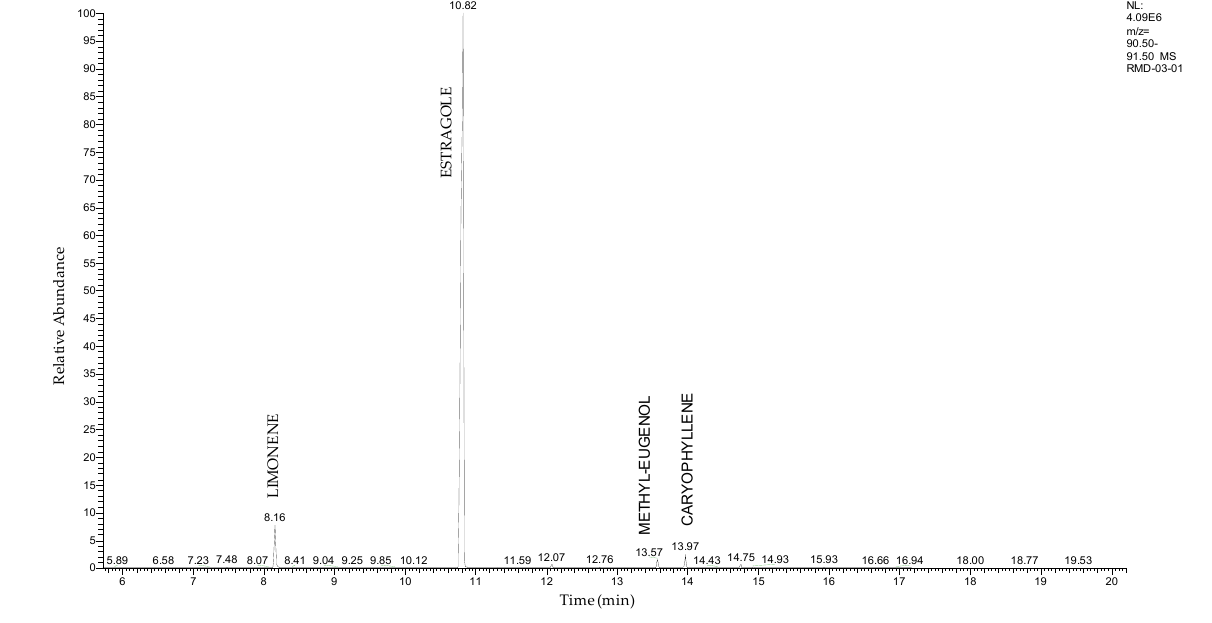
Figure 2. Total ion chromatogram of the EO from A. foeniculum AdB using GC–MS.